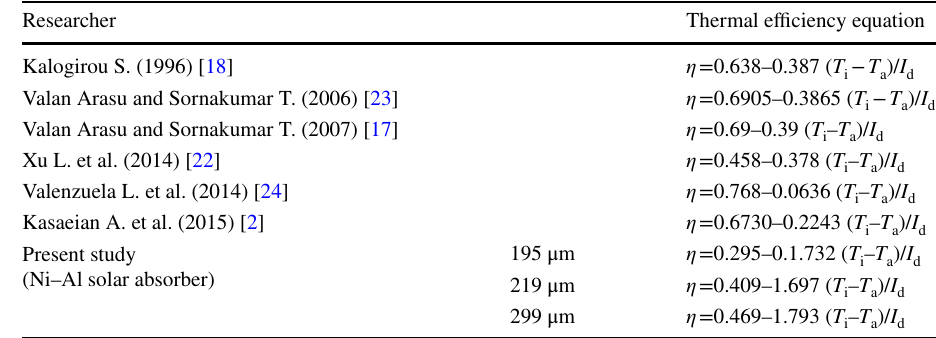
Table 3 Comparison of the thermal efficiency equation of this present study to previous